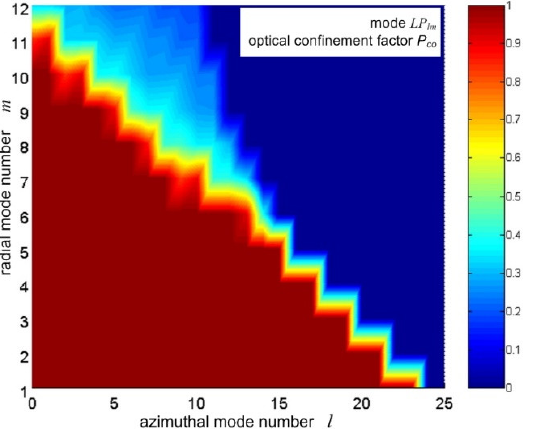
Figure 3. Optical confinement factor distribution over the mode staff of a reference 100 μm core multimode optical fiber (MMF).